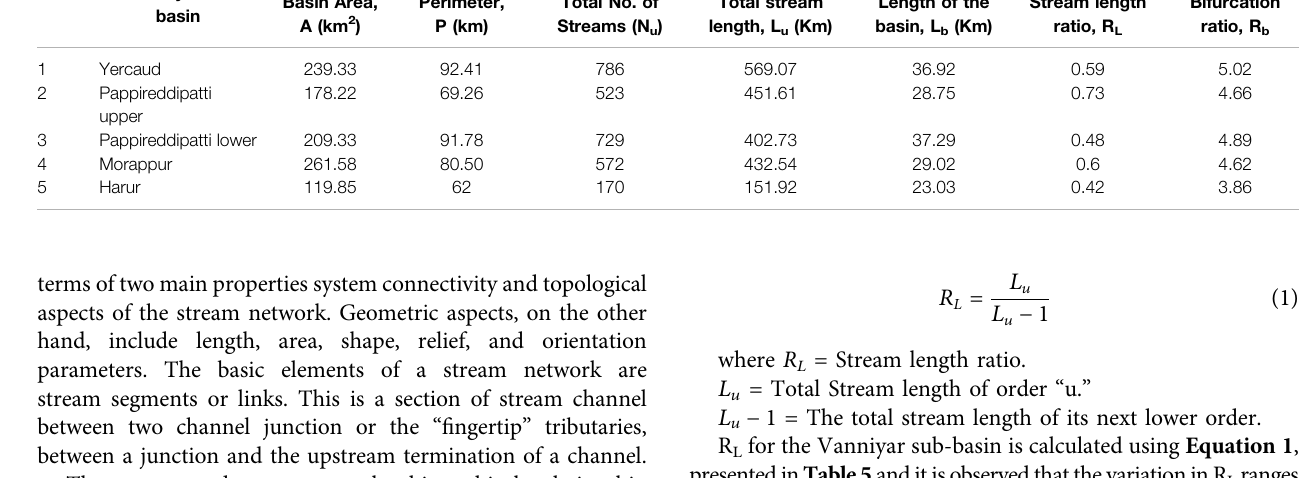
TABLE 5 | Morphometric Parameters of the Vanniyar ’ s sub-basin, Dharmapuri district, Tamil Nadu, India. S.No Name of the Vanniyar ’ s